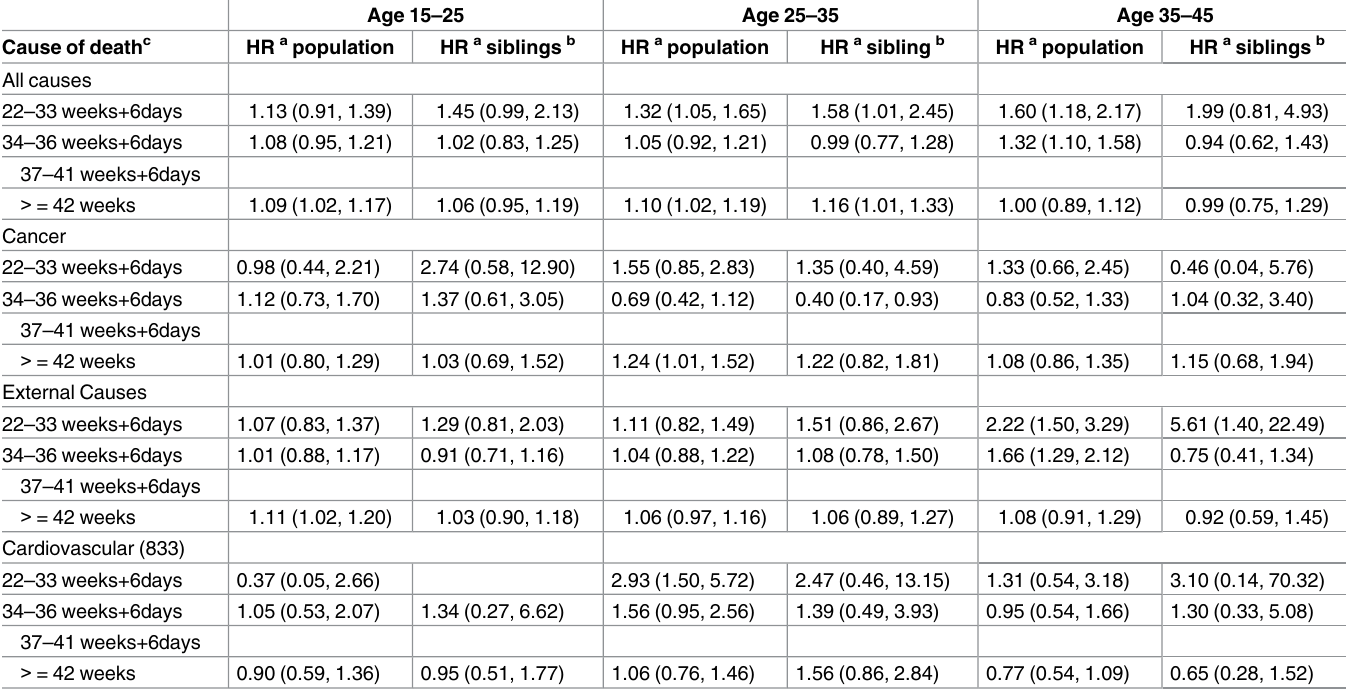
Table 4. Mortality and gestational age by cause of death. Nation-wide cohort born in Norway 1967–1997. Analyses stratified by age at